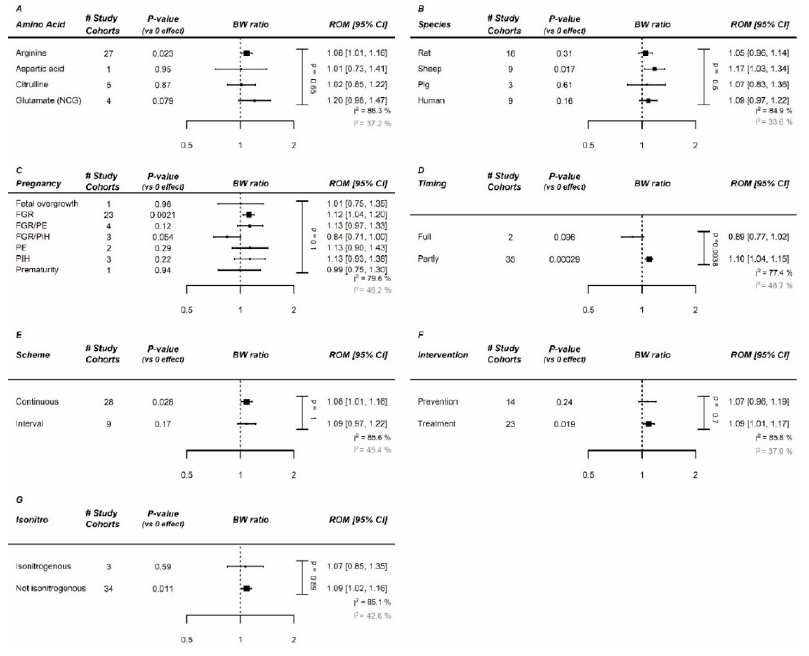
Figure 2. Meta-regression of arginine family on fetal/birth weight (BW) in complicated pregnancies. Meta-regression in complicated pregnancies on ( A ) amino acids (AA); ( B ) species; ( C ) pregnancy complication; ( D ) administration duration; ( E ) administration scheme; ( F ) Intervention type (prevention vs. treatment); ( G ) isonitrogenous vs. non-isonitrogenous in control arms. NCG and arginine are the most effective AAs and the largest effect is observed in sheep models of pregnancy complication. Data represent pooled estimates expressed as ratio of means (ROM) with 95% confidence interval (CI) using a random effect model. Residual I 2 is shown, and in grey the residual I 2 after removal of the outlier Sharky et al. FGR, fetal growth restriction; I 2 , heterogeneity; PE, preeclampsia; PIH, pregnancy induced hypertension.